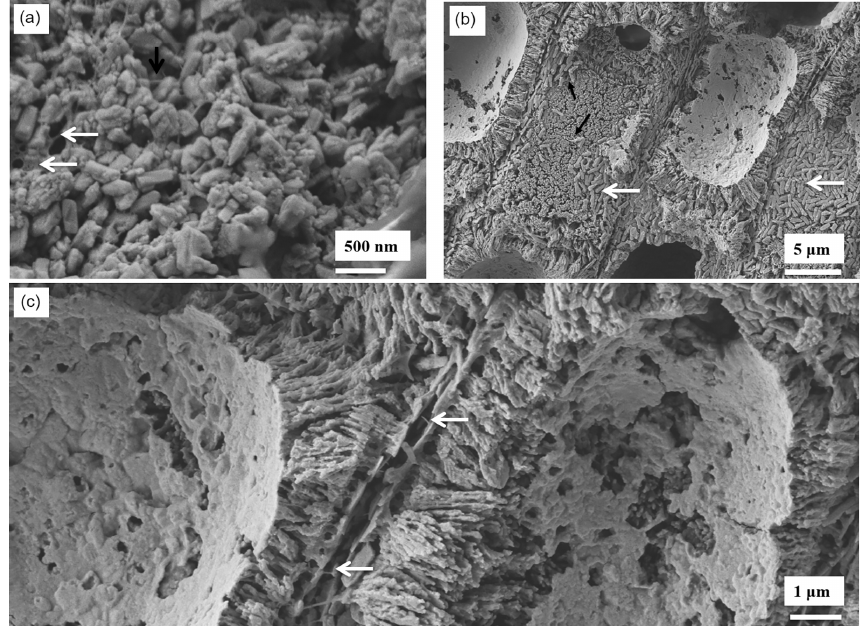
Figure 9. Interfilament structures in K. epilaeve (a) and L. laeve (b, c) . (a) K. epilaeve etched for 20min. Fibrils (black arrow) and porous membrane (white arrows). (b) L. Laeve etched for 20min. Interfilament grains are flattened against the external sides of the cell wall (white arrows) attached by fibrils (black arrows). (c) Fibrils visible stretched across the space between cell walls with two layers of interfilament grains (white